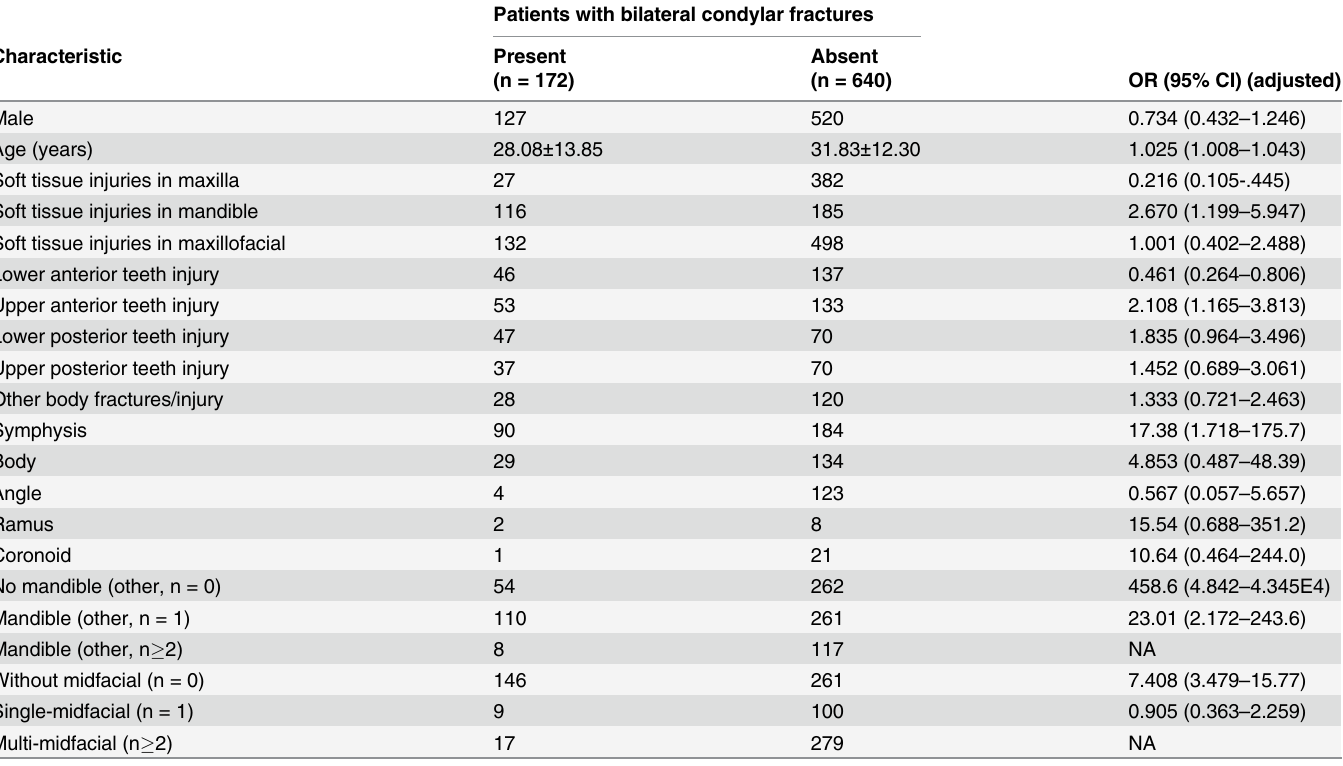
Table 5. Multivariate logistic regression analysis of patients with bilateral condylar fractures. Patients with bilateral condylar